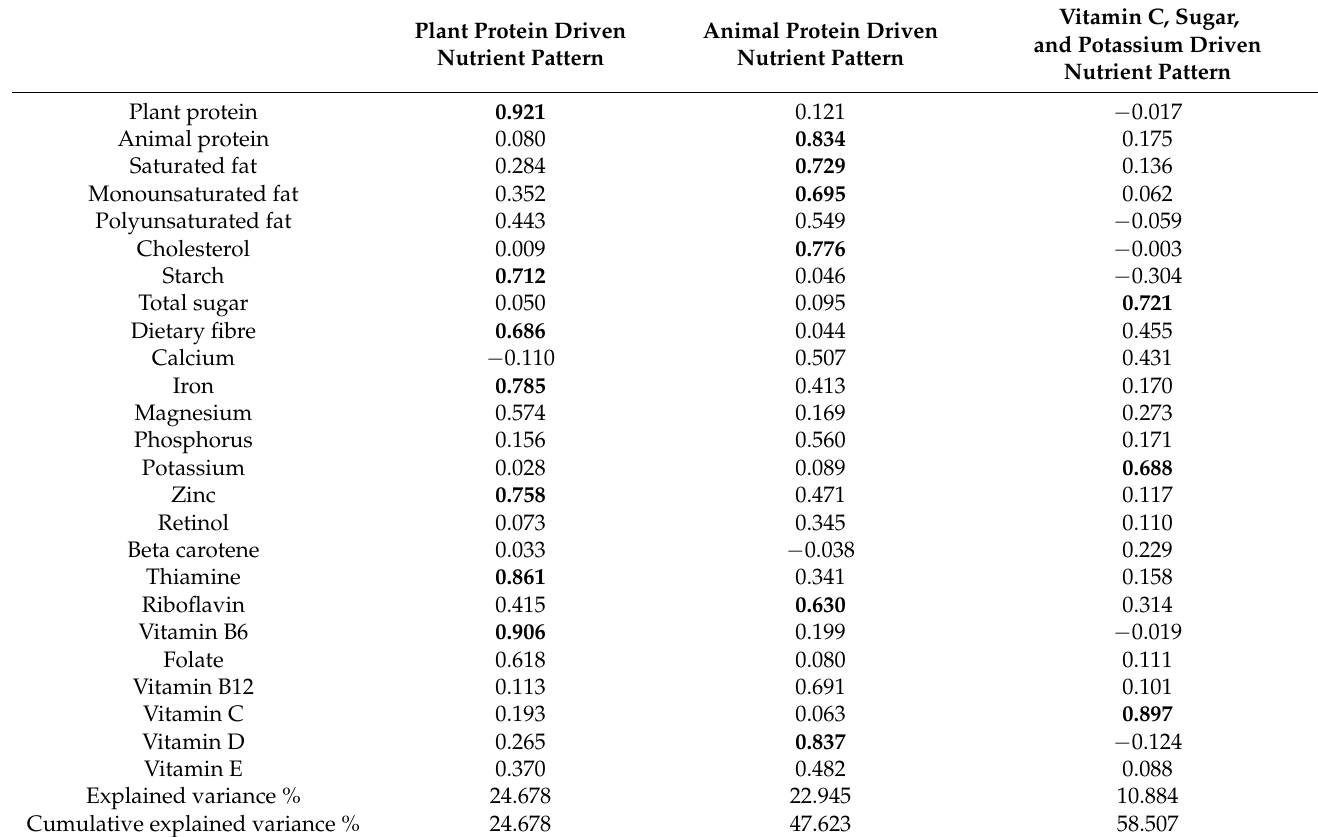
Table 2. Factor loadings and explained variances for the nutrient patterns. Plant Protein